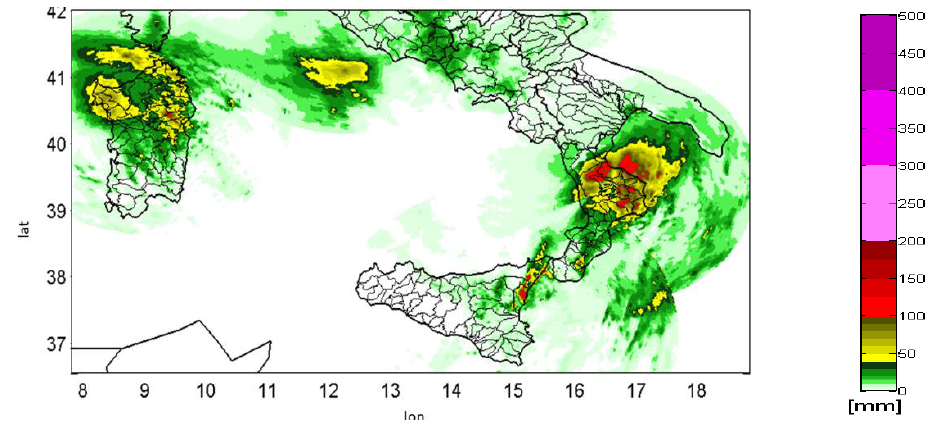
Figure A2. Example of radar accumulation, over the same spatio-temporal domain.